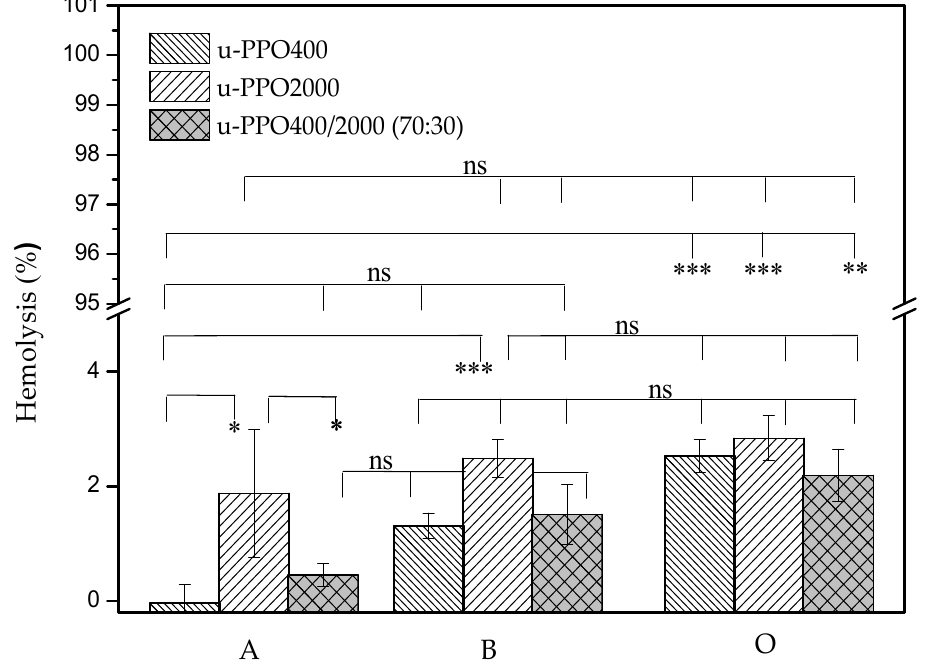
Figure 6. Percentage of hemolytic potential between u-PPO400 and u-PPO400/PPO2000 (70:30) against blood types A, B, and O. Results are expressed as the mean ± SD of triplicates ( n = 3). * p < 0.05, ** p < 0.01, *** p < 0.001, ns: no significant difference.